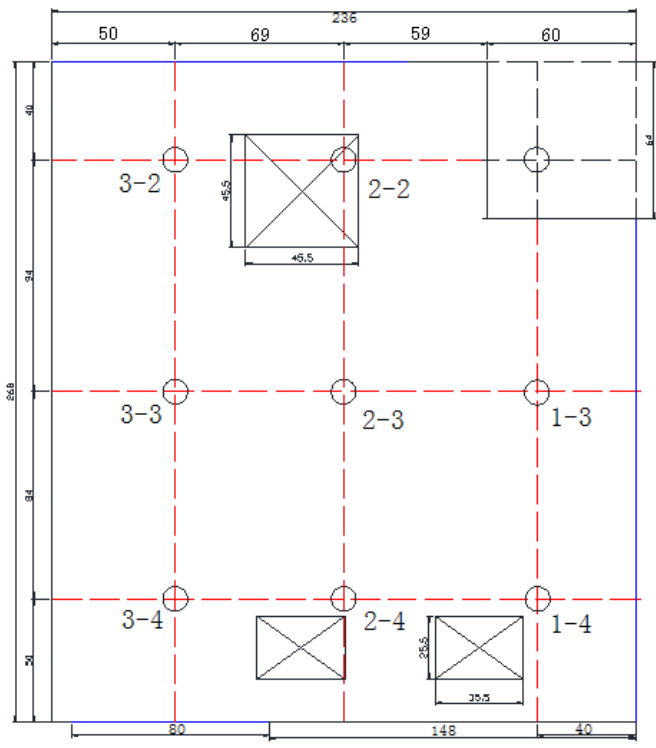
Figure 16. Sensor installation.